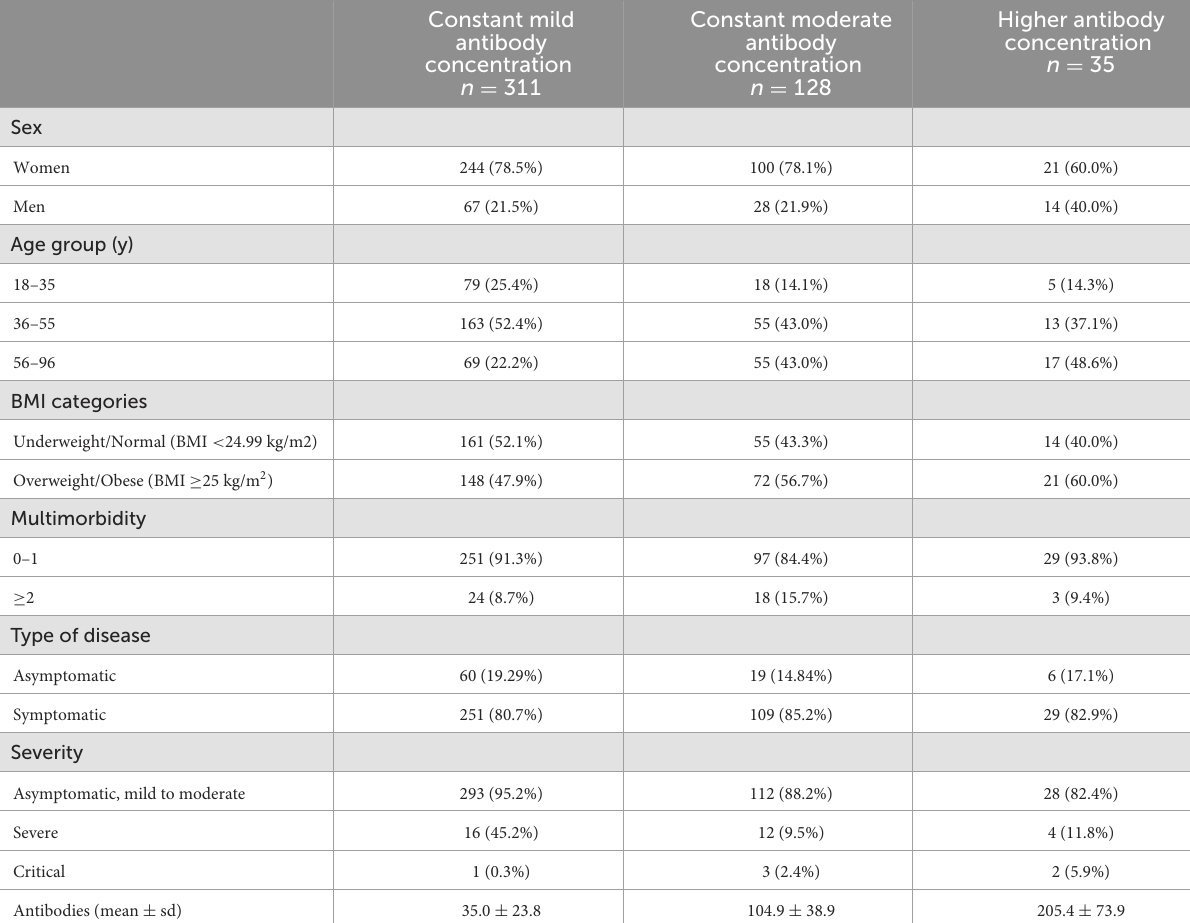
TABLE 5 Baseline characteristics according to antibody concentration